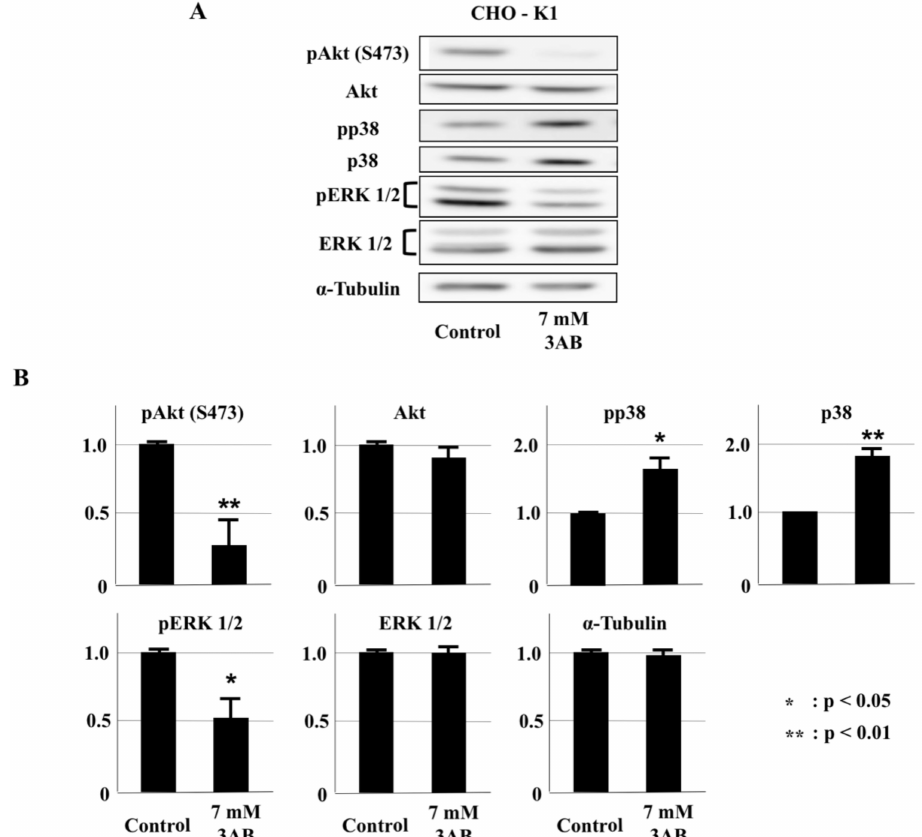
Figure 4. The PARP inhibitor 3AB reduced phosphorylated Akt levels. ( A ) The cell proliferation signaling proteins p38 MAPK, ERK 1/2 and Akt, together with their phosphorylated proteins, were detected by immunoblot analysis after CHO-K1 cells were treated with 7 mM 3AB for 48 h. α -Tubulin is shown as a loading control. ( B ) The relative intensities of Western blots from 3 experiments are summarized. Significance was assessed against the control. * p < 0.05. ** p <